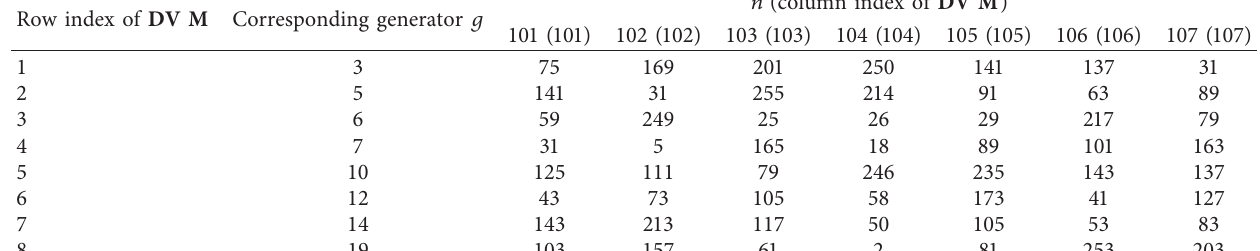
Table 1: Discrete logarithm values of 101 to 107 under the first eight generators. Row index of DV M Corresponding generator g